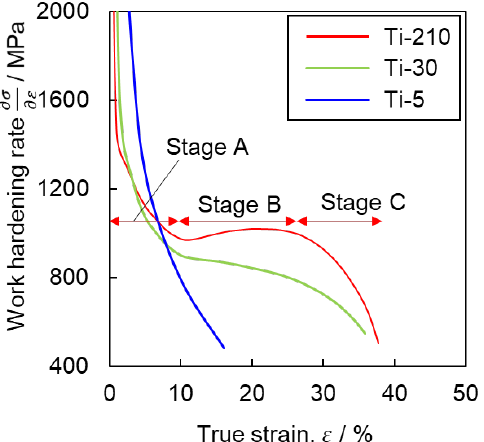
Figure 15. Work-hardening rate – true strain curves obtained from tensile tests at high strain rates (10 0 s −1 ).